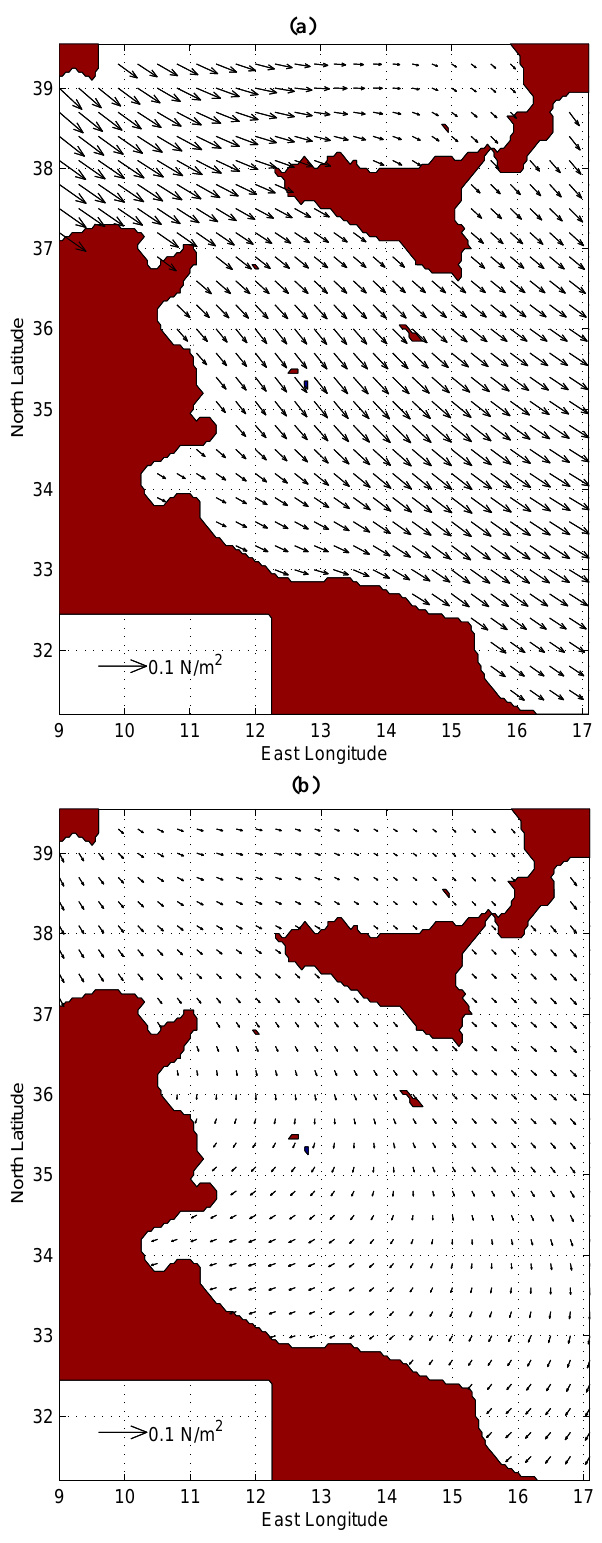
Fig. 3. The monthly averaged wind stress fields in (a) February and (b) August derived from the ECMWF Re-Analysis (ERA) data set covering the period from Jan. 1979 – Dec. 1993. One vector every four grid points is plotted. Units are N/m 2